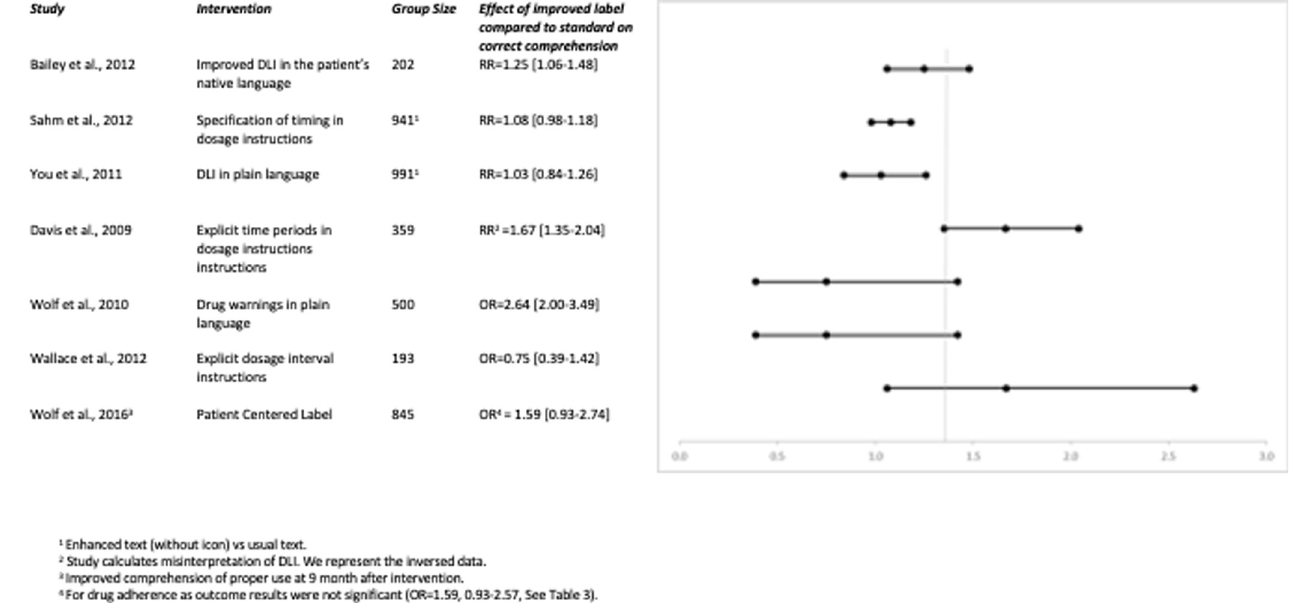
Fig 3. Relative risks and odds ratios of interventions in DLI on correct comprehension.